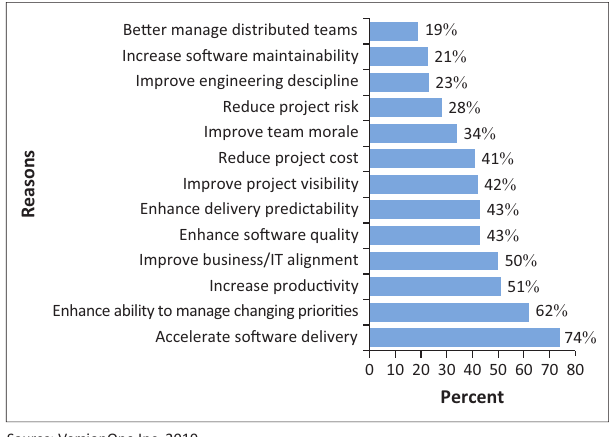
FIGURE 1: Reasons for adopting Agile